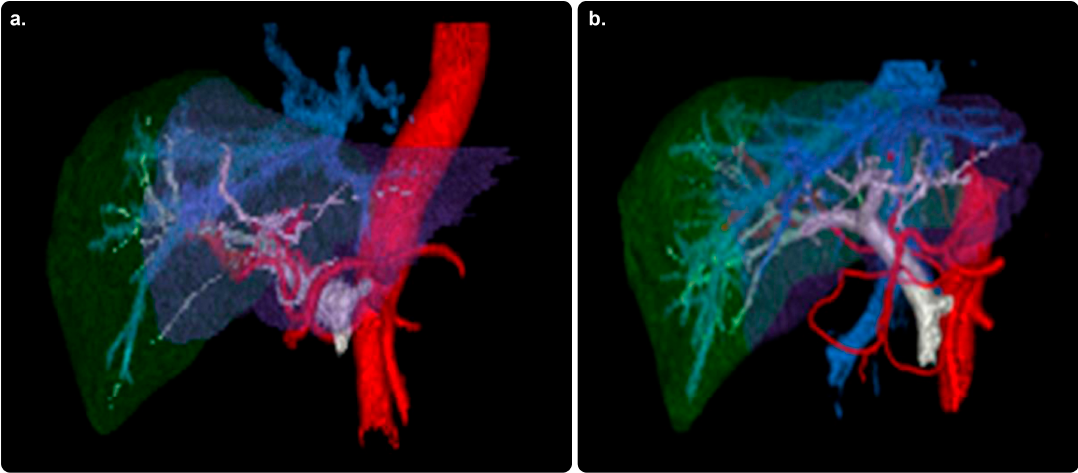
Figure 4. Hepatic VCAR software and its role in therapy planning. Color-enhanced 3D volume- rendered images of livers from two patients ( a , b ) with hepatic malignancies. 3D, three-dimensional; red, hepatic arteries arising from the aorta; blue, hepatic veins leading to the inferior vena cava; gray, portal venous system; green, right-lobe liver parenchyma; purple, left-lobe liver parenchyma. Reprinted from “Comparative analysis of three-dimensional volume rendering and maximum in- tensity projection for preoperative planning in liver cancer” by Ho et al. [23] with written approval from the corresponding author and publisher (European Journal of Radiology Open; Copyright 2020).